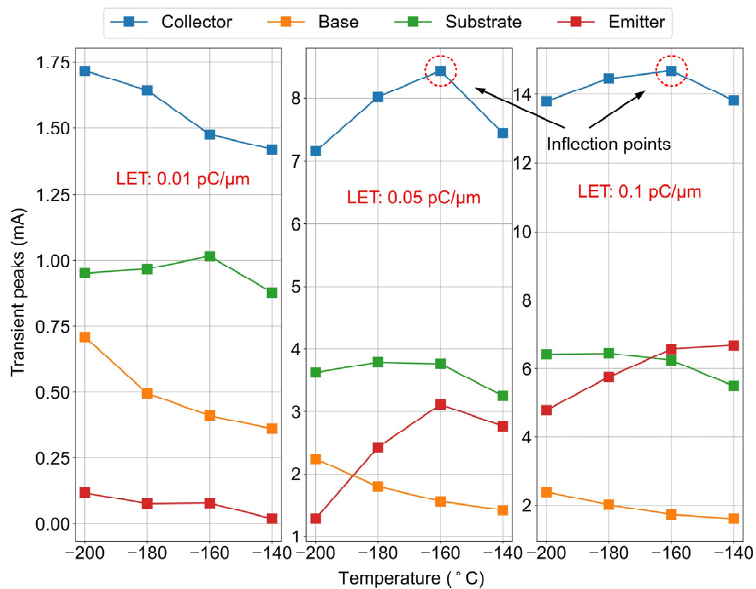
Figure 5. The transient peaks (absolute values) of the four device electrodes from the TCAD simula- tion at cryogenic temperatures with different LET values.